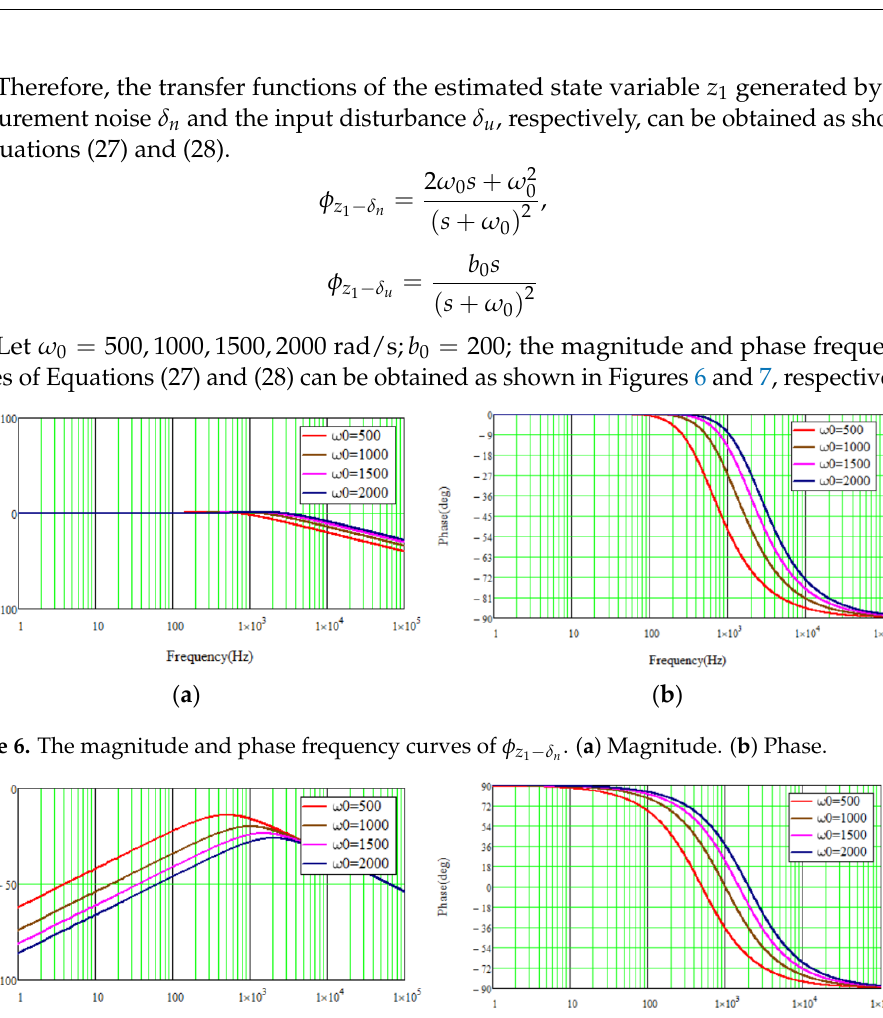
 . ( a ) Magnitude. ( b ) Phase. − . ( a ) Magnitude. ( b ) Phase. 1 − δ u 1 u z 